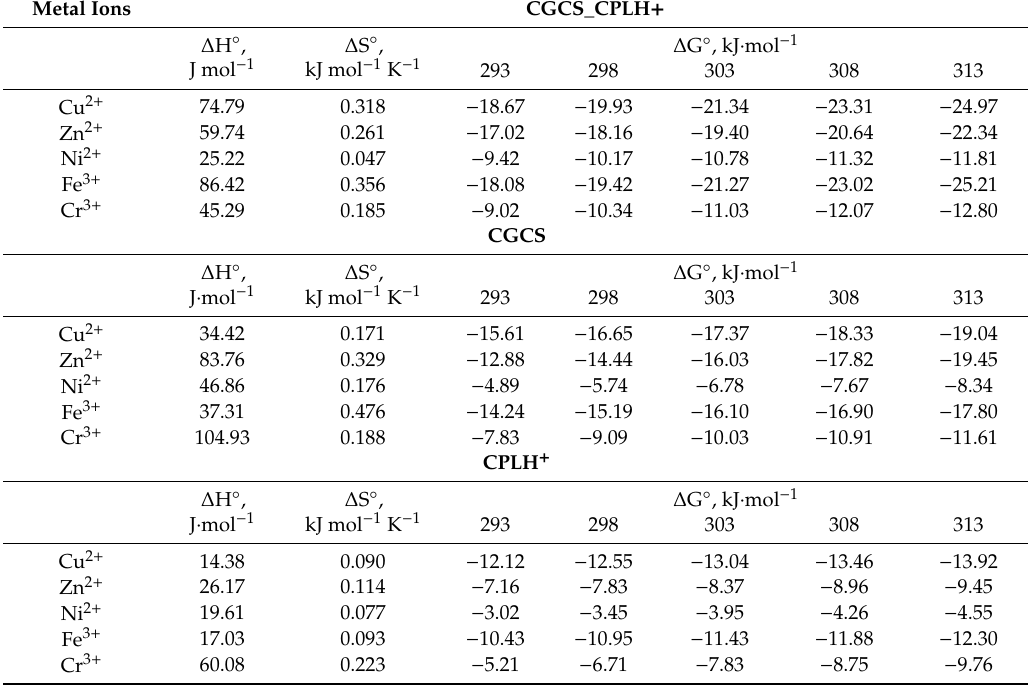
Table 3. Thermodynamic parameters for the sorption of Cu 2 + , Zn 2 + , Ni 2 + , Fe 3 + , and Cr 3 + ions onto investigated